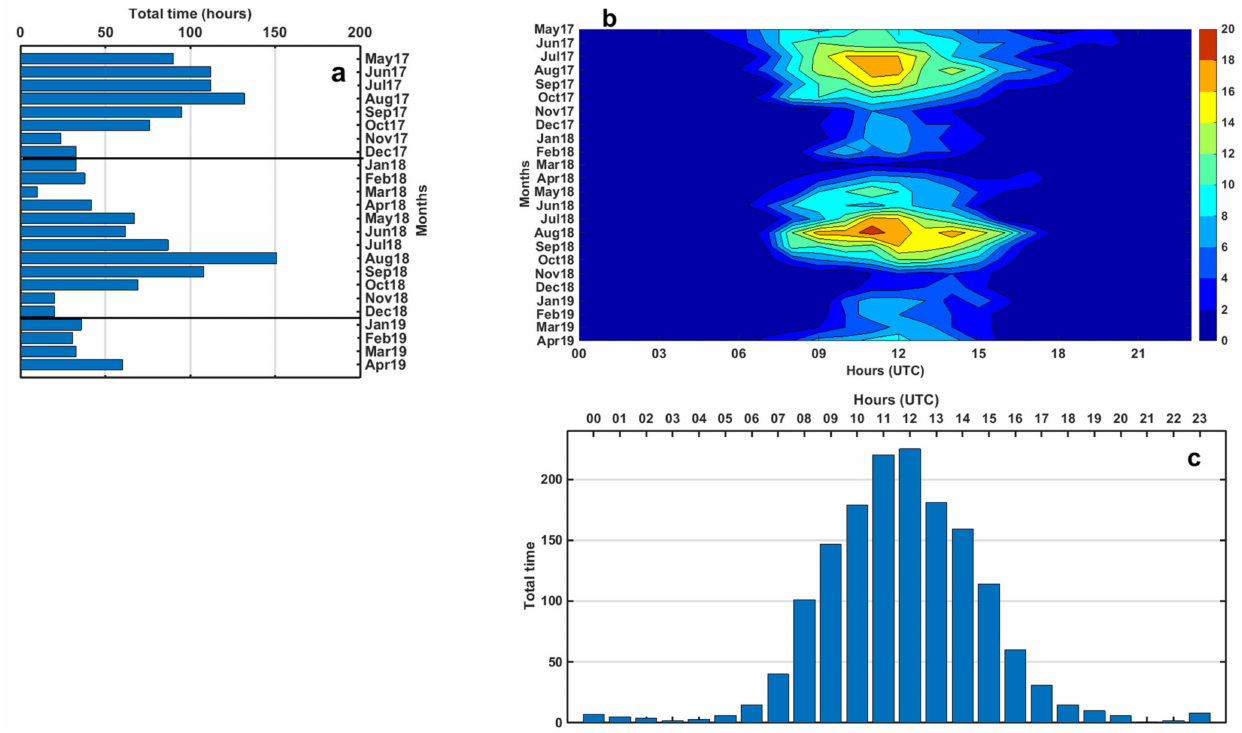
Figure 5. Lake breeze occurrences in hours representing monthly ( a ), daily cycle per month ( b ) and daily cycle for the whole period ( c ). Grey horizontal lines in panel ( a ) separate the years 2017, 2018 and